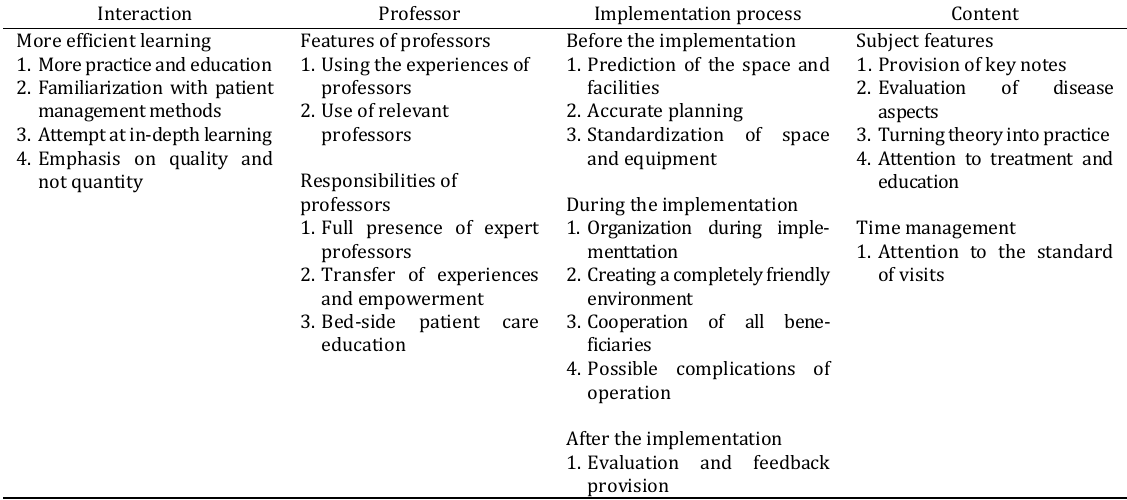
Table 5. Quality indicators of clinical education operation and procedures from the perspective of